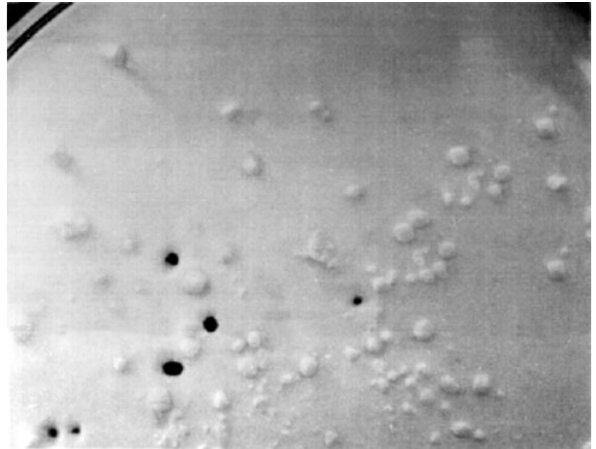
Figure 21. These siliceous accretions were formed experimentally in a gel paste and were also produced in a number of other col- loidal materials. The formation of accretions requires thick pastes and achieving steady rates of uniform shear throughout concen- trated thixotropic gelatinous materials that are normally gelatinous solids. This imposed some limitations to the laboratory work [From Healy 11 , 1973 Accretion of colloidal material, p.9, fig